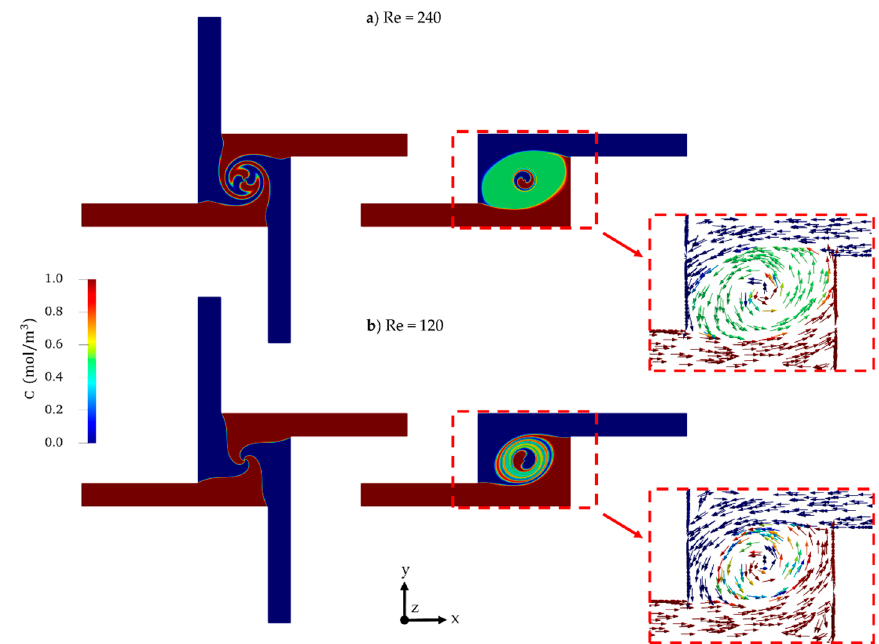
Figure 12. Central plane of mixing box at z = 50 µ m: ( a ) Four- and two-inlet micromixer designs at Re = 240 and ( b ) four- and two-inlet micromixer designs at Re = 120. Arrows in dashed rectangles show velocity vectors on the plane colored by scalar values. Images show scalar transport at the M1 mesh level.